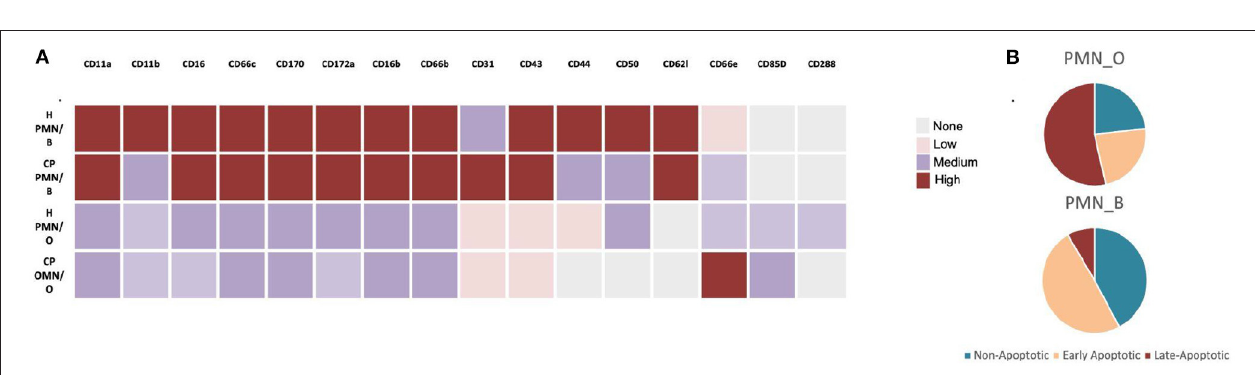
FIGURE 2 | Oral vs. Blood Neutrophil Phenotypes. (A) Comparison of cluster differentiation expression levels of oral (O) and blood (B) neutrophils in oral- health (H) vs. chronic periodontal disease (CP). (B) Apoptotic profile of oral vs. blood neutrophils in otherwise healthy individuals. Illustrated here as described by [62, 63],